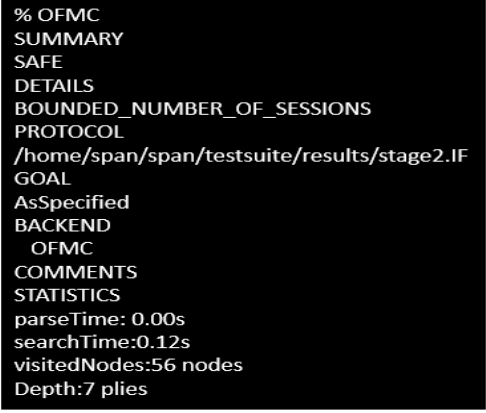
Figure 7. Simulation outcome in stage